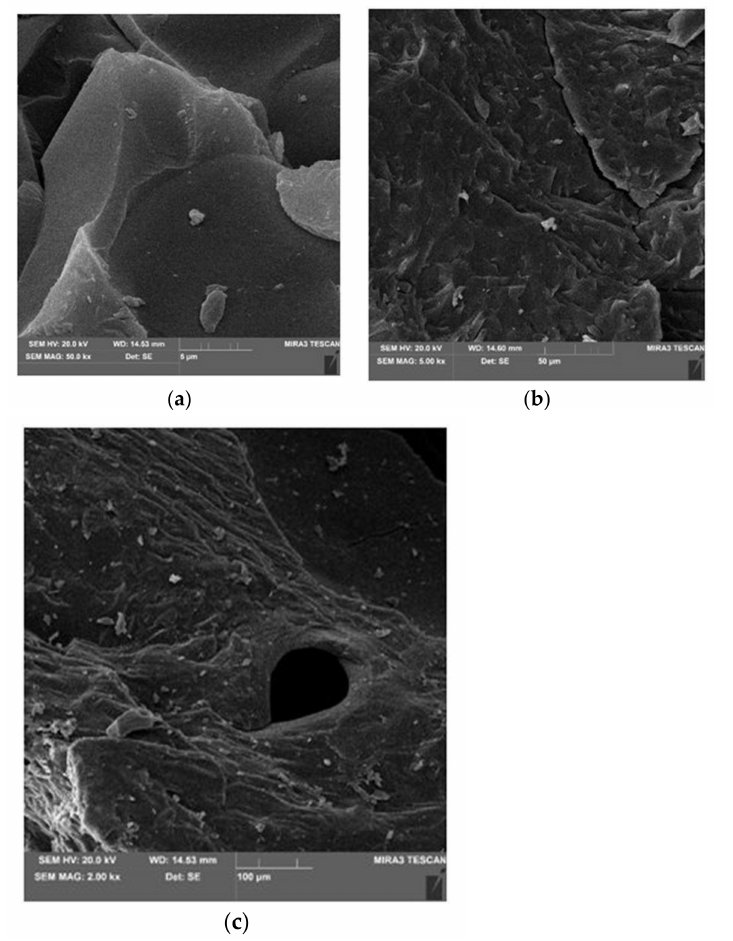
Figure 8. The nature of the microstructural surfaces of the waste material. SEM image: ( a ) semicircular shell fracture, ( b ) surfaces with a spiked, uneven fracture, ( c ) oval, unfilled